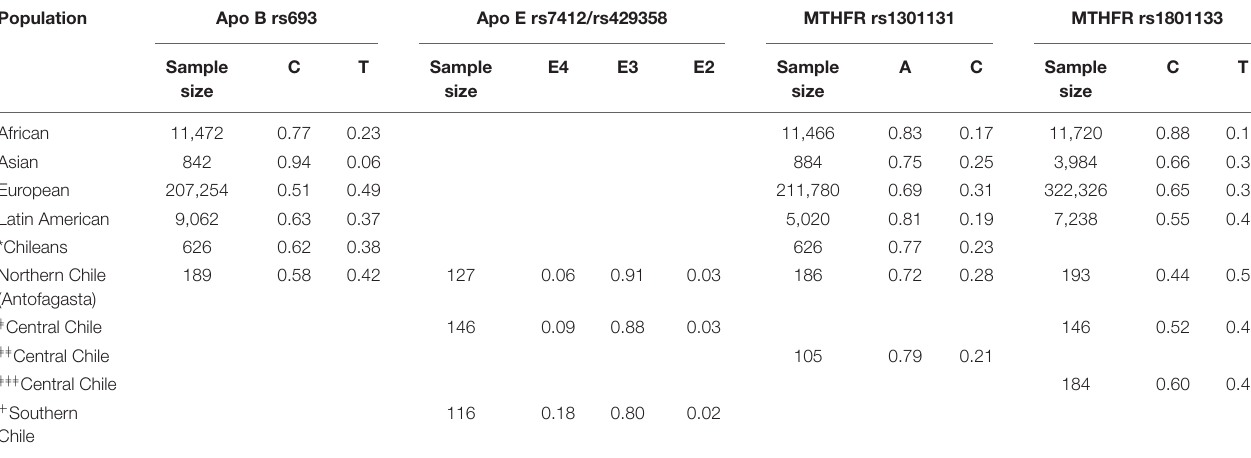
TABLE 4 | Allele frequencies for APOB , APOE , and MTHFR polymorphisms in population worldwide and Chilean subjects from different regions.